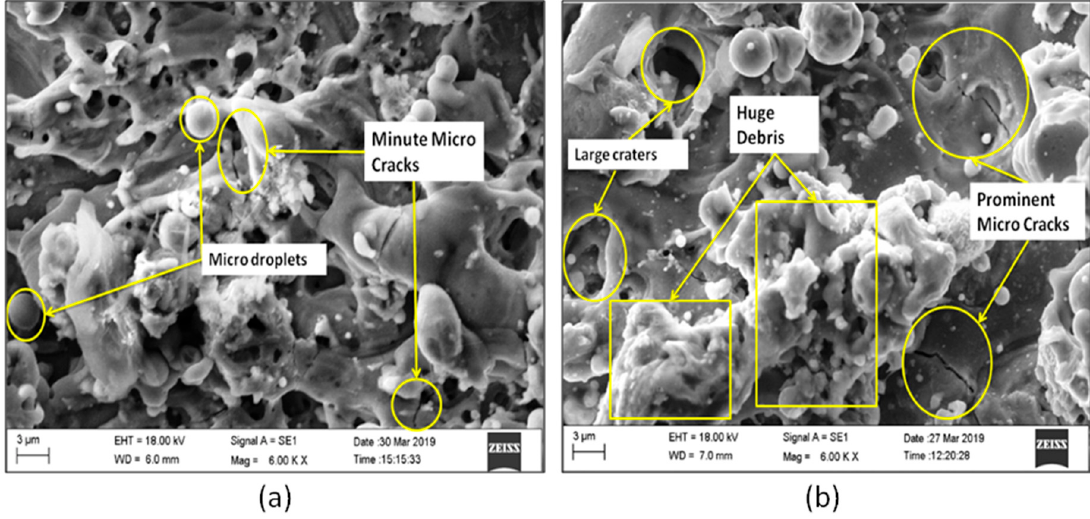
Figure 5. Surface morphology for higher and lower MRR: ( a ) SEM image for lower MRR and ( b ) SEM image for higher MRR.